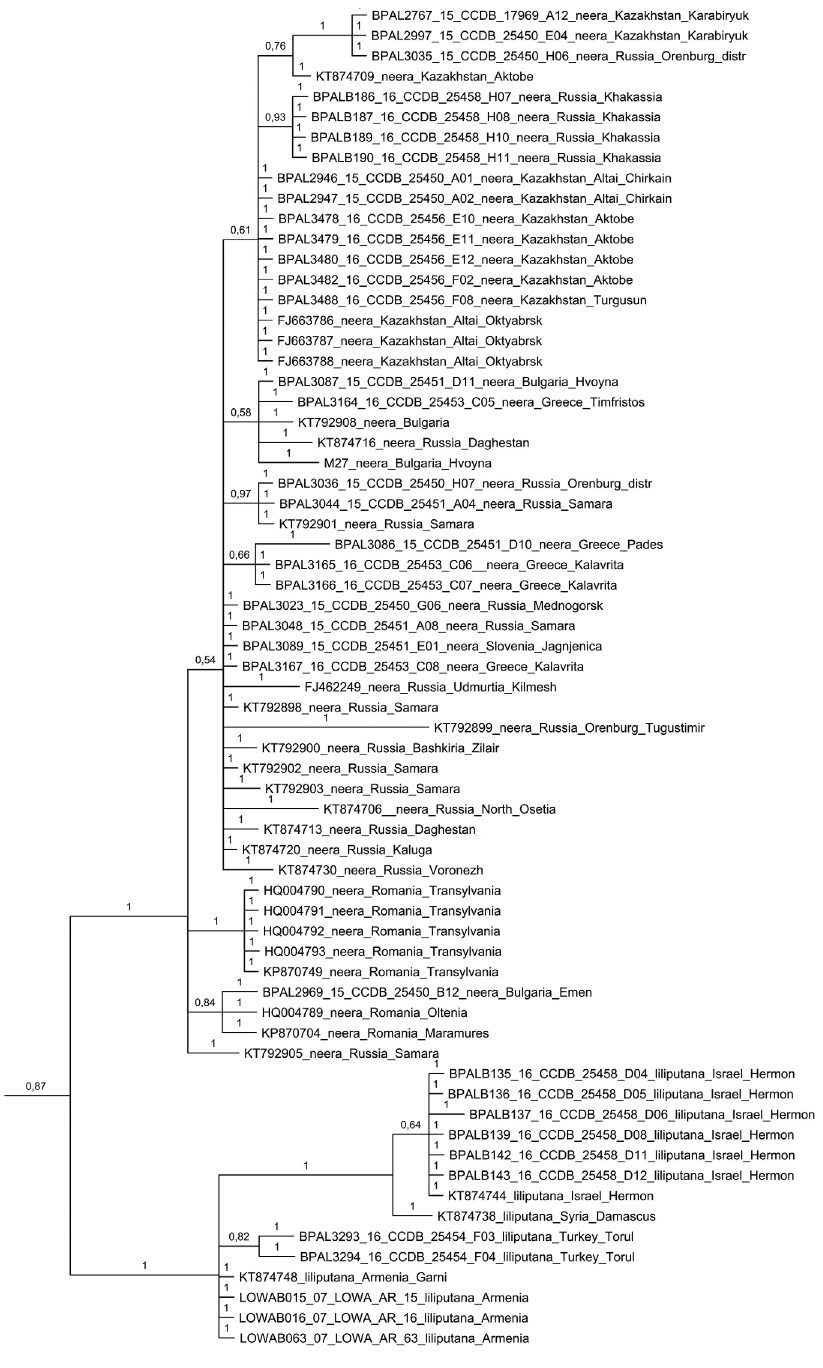
Figure 3. Fragment of the Bayesian tree of Melitaea didyma complex (haplogroups neera and liliputana ) based on analysis of COI gene. Numbers at nodes indicate Bayesian posterior